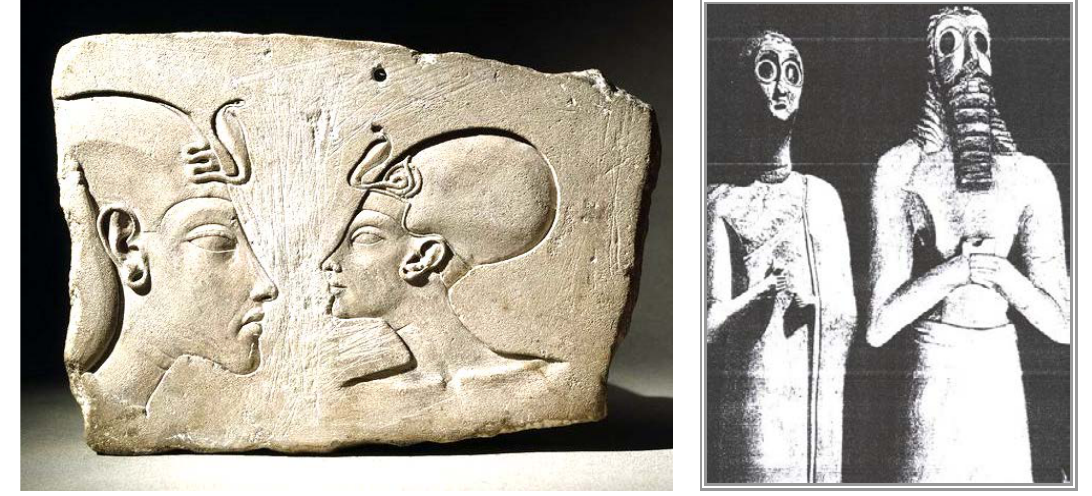
Figure1 The witbour plaque,Museum relief; Akhenten&Nefertiti,1352- 1336 BC,broooklyn.